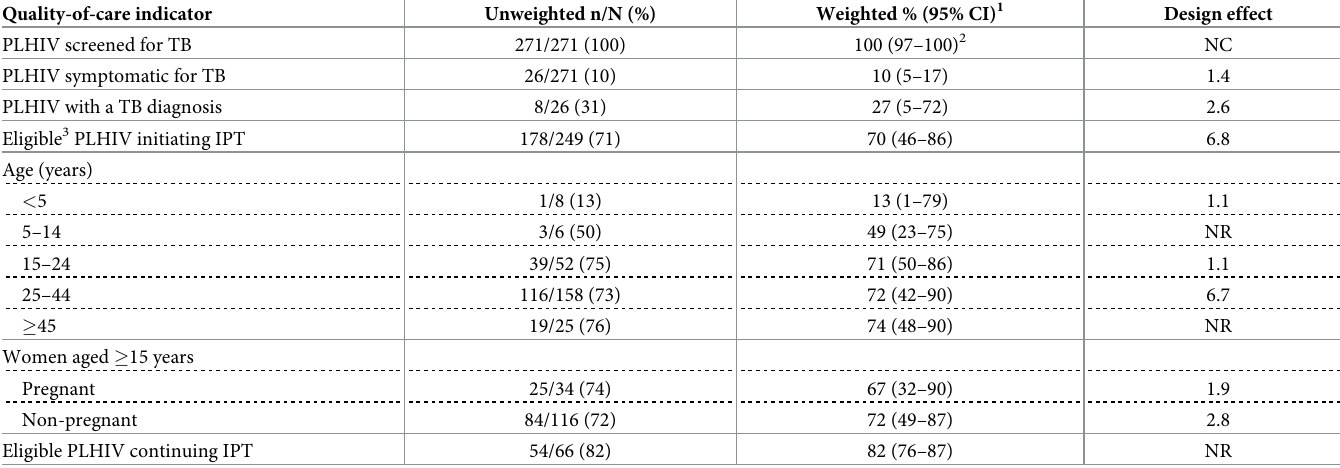
Abbreviations: CI, confidence interval; TB, tuberculosis; NC, not calculated; NR, not reported for calculated design effects < 1.0. 1 Taylor series variance estimates for cluster sampling design. 2 Exact confidence limits calculated using per-protocol assignment of design effect = 2. 3 Eligible PLHIV excluded those with confirmed or suspected TB or with pre-existing peripheral